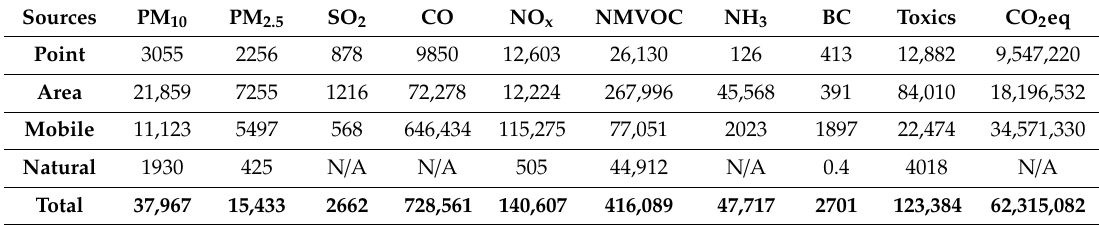
Table 2. Annual emissions (tons per year) of the MCMA for the year 2016.